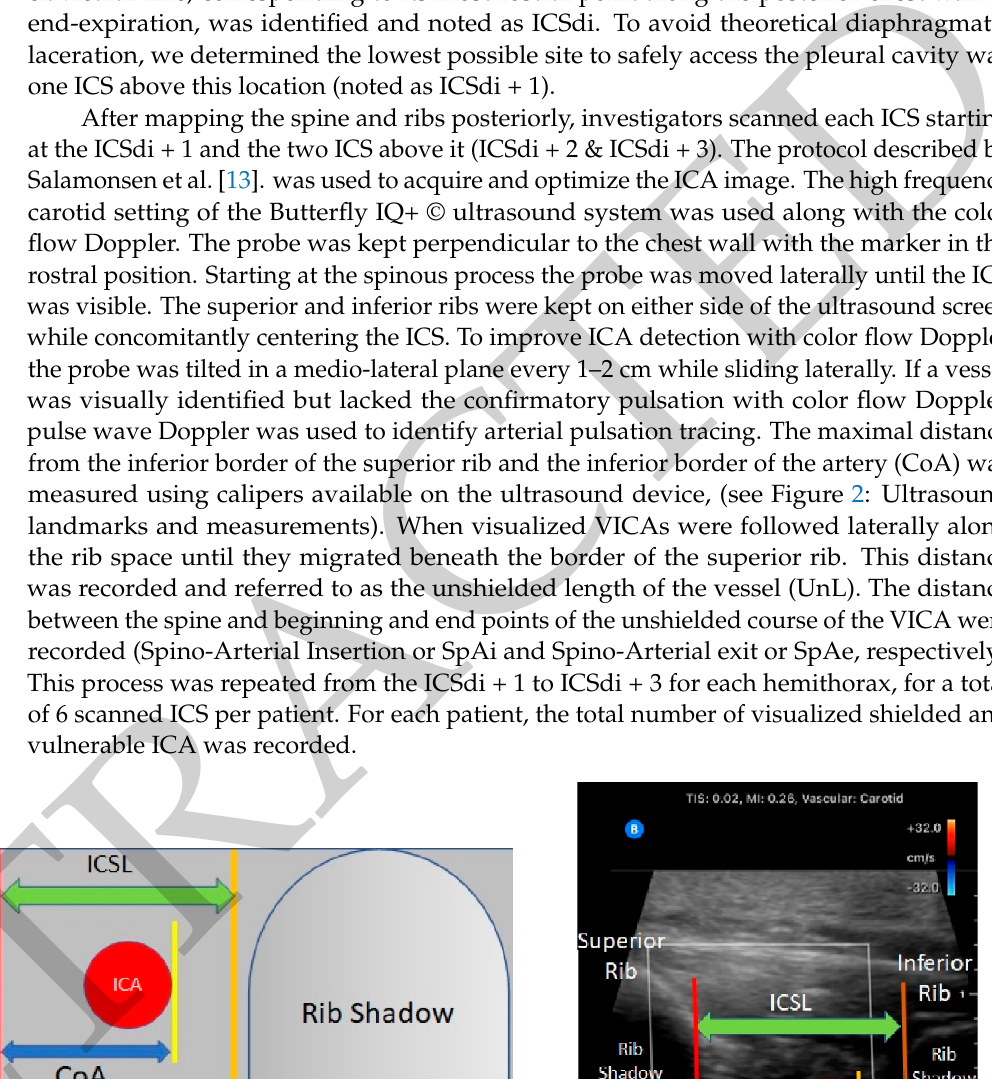
3 of 7 Figure 1. Spinal and Rib mapping. ( a ) Schematic representation, ( b ) Measurements on patient’s back. Legend: Blue line depicts the diaphragm. ICSdi: refers to the ICS at mid-axillary line where the diaphragm was seen ICSdi + 1 to +3 refers to ICS level above the ICSdi and represent the scanned